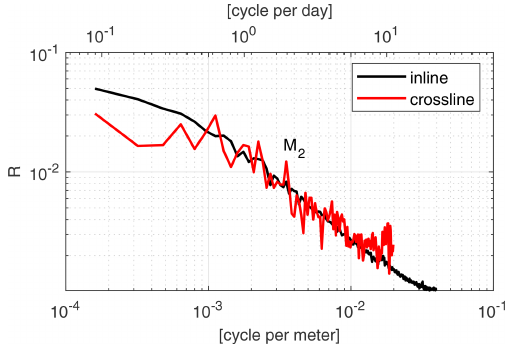
Figure 10. Inline and crossline spectra. The crossline spectrum is associated with both time and space cycles (with a ratio of 0.001666cpm/cpd) calculated from the Fourier transform of the crossline variation in the timescale and from that in the space scales, respectively. The inline spectrum is only associated with the space cycle, calculated from the Fourier transform of the inline variation. The semi-diurnal ( M 2 ) tidal cycle is also denoted (at 2cpd, or about 3 . 3 × 10 − 3 cpm in the space